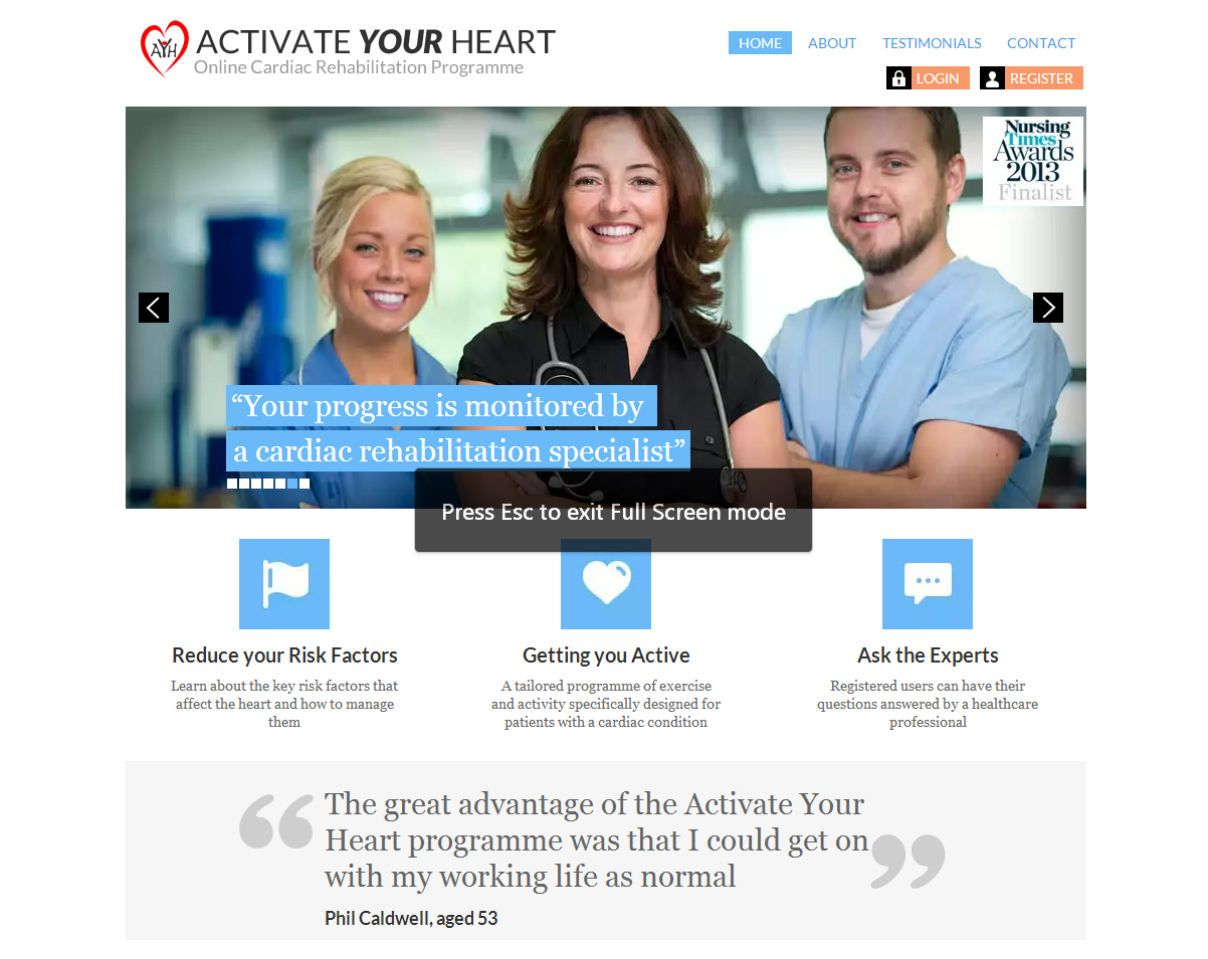
Figure 1. Activate Your Heart